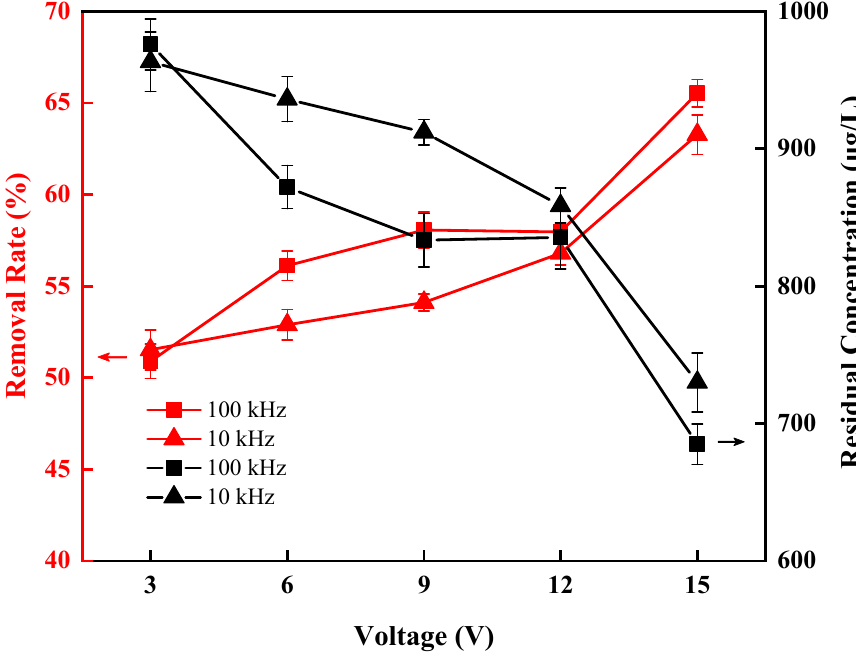
Figure 8. Effect of frequency on direct removal of Anabaena by DEP.